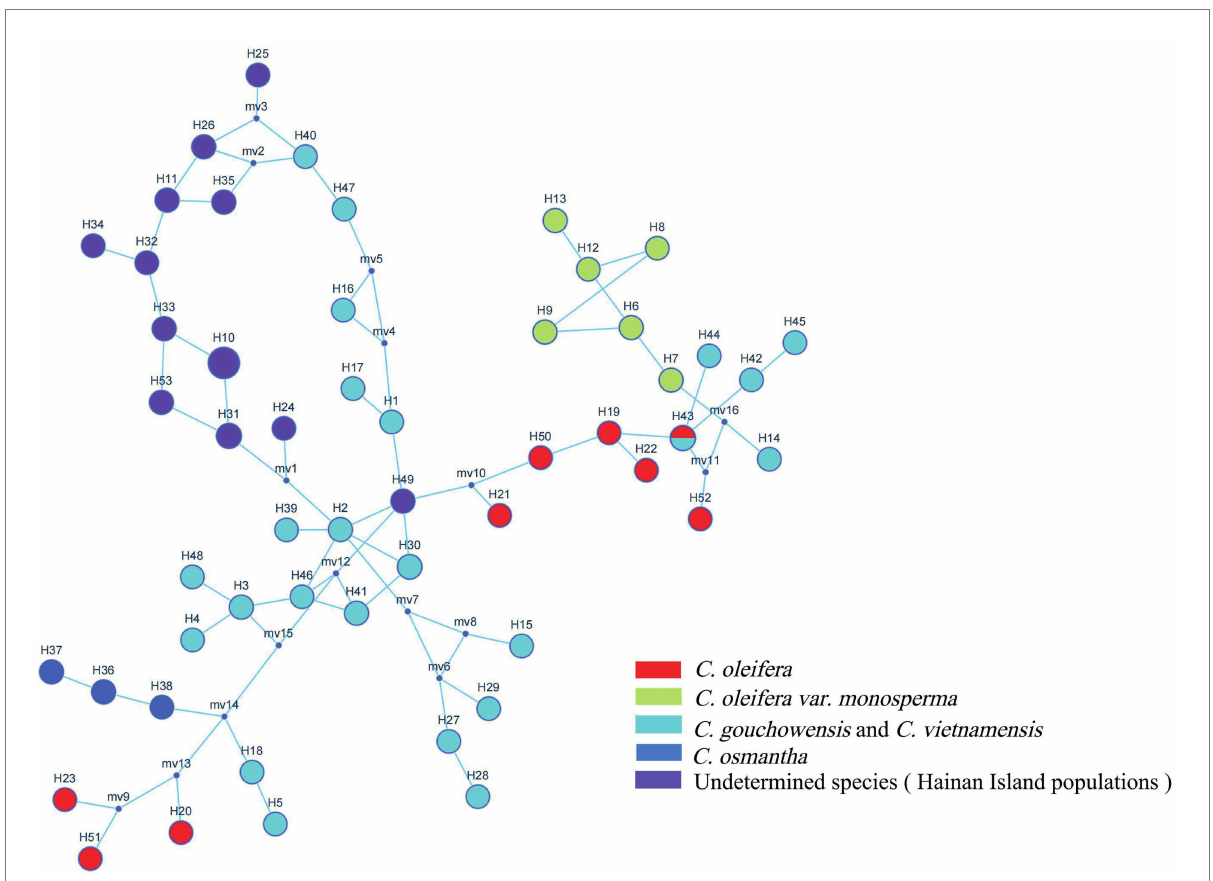
FIGURE 10 TCS network of the 53 cpDNA haplotypes of the test